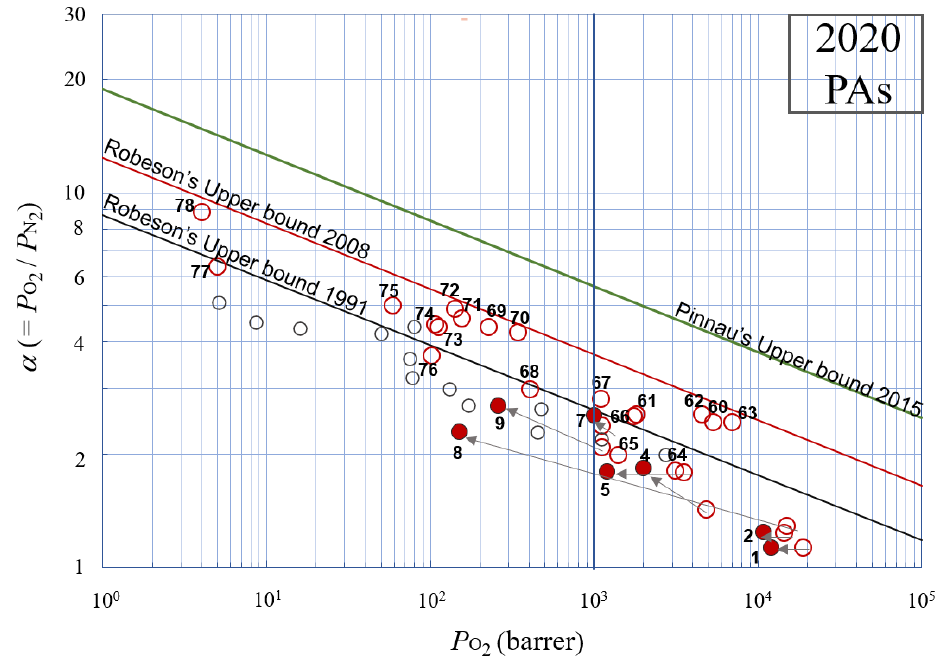
Figure 7. Plots of oxygen permselectivity through polyacetylenes (PAs), showing the highest α at each P O 2 reported in the literature in 2020 ( ● : after aging, ○ : before aging). For the data and categorization of the plots, see Table 5, and for the chemical structures of the polymers in the plots, see Charts 1 and 5.